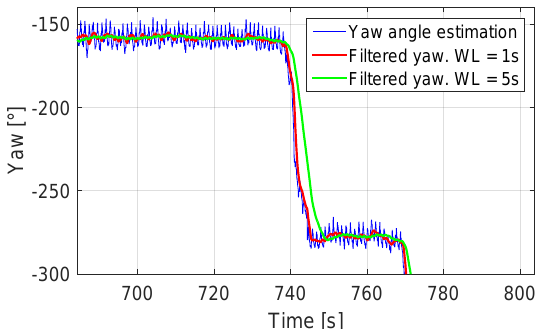
Figure 3. The blue curve represents the yaw angle estimation, the red curve is the filtered yaw angle estimation with a window length of 1s and the green curve is the result of filtering the yaw angle with a window length of